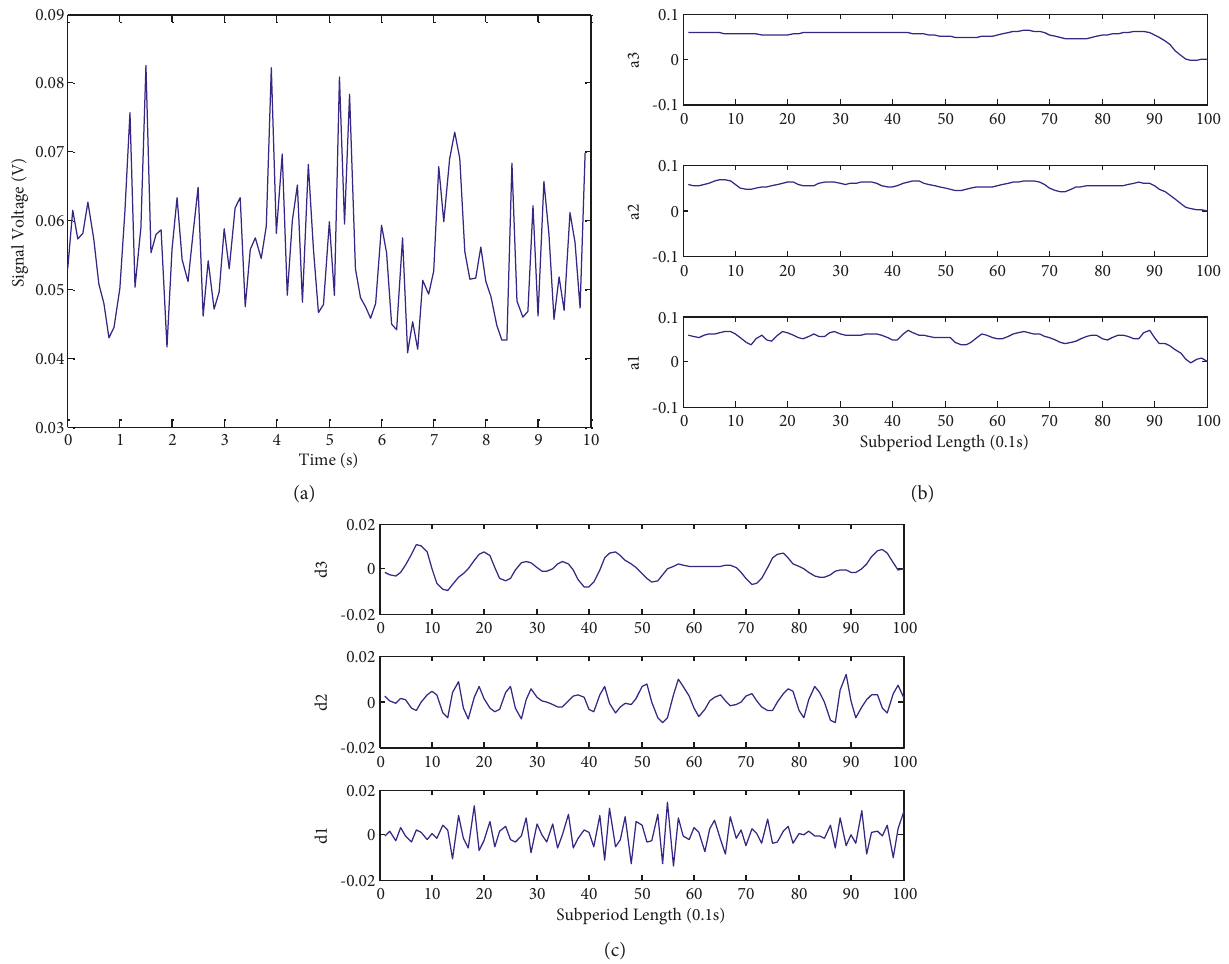
Figure 5: (a) FFT signal with solid to air mass ratio 1.0 and gas flow of 160m 3 /h; (b) wavelet transform approximation signal; (c) wavelet transform detail